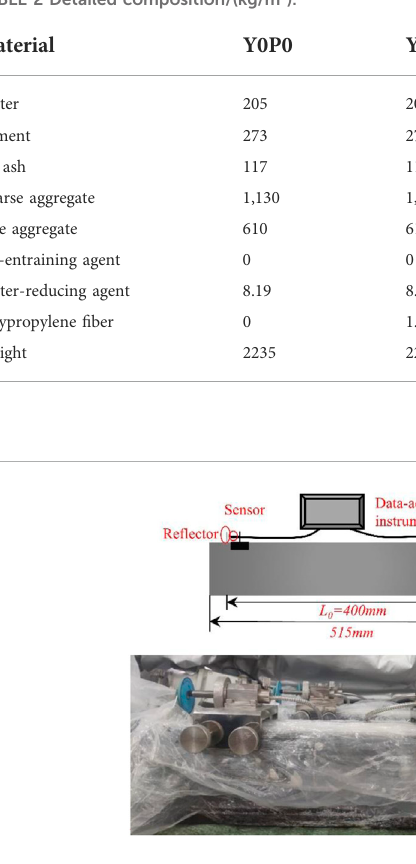
FIGURE 1 Non-contact concrete shrinkage tester.